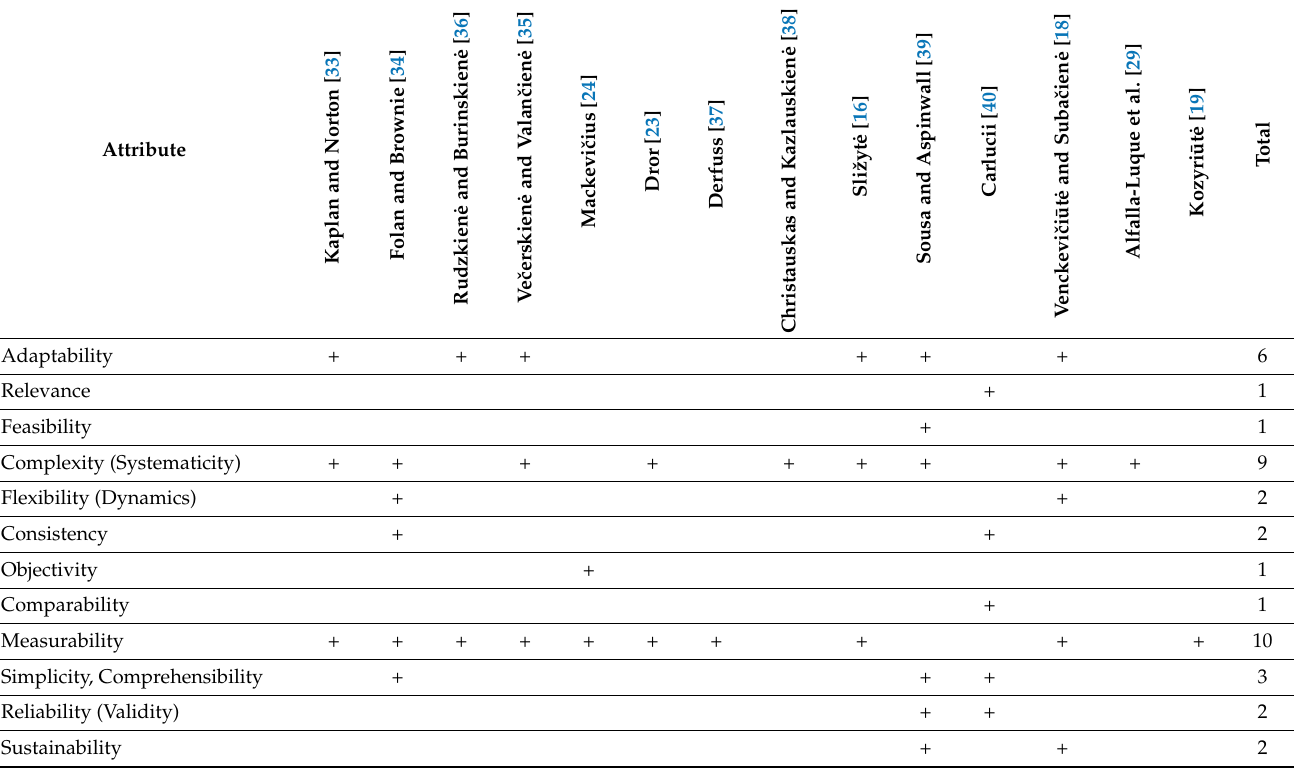
Table 2. Attributes of the analysis methods for evaluating an organization’s